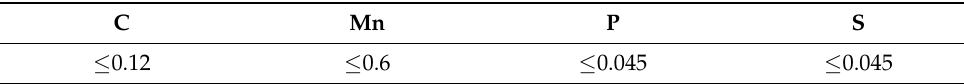
Table 1. Chemical compositions of the DC01 steel (EN 10130). C